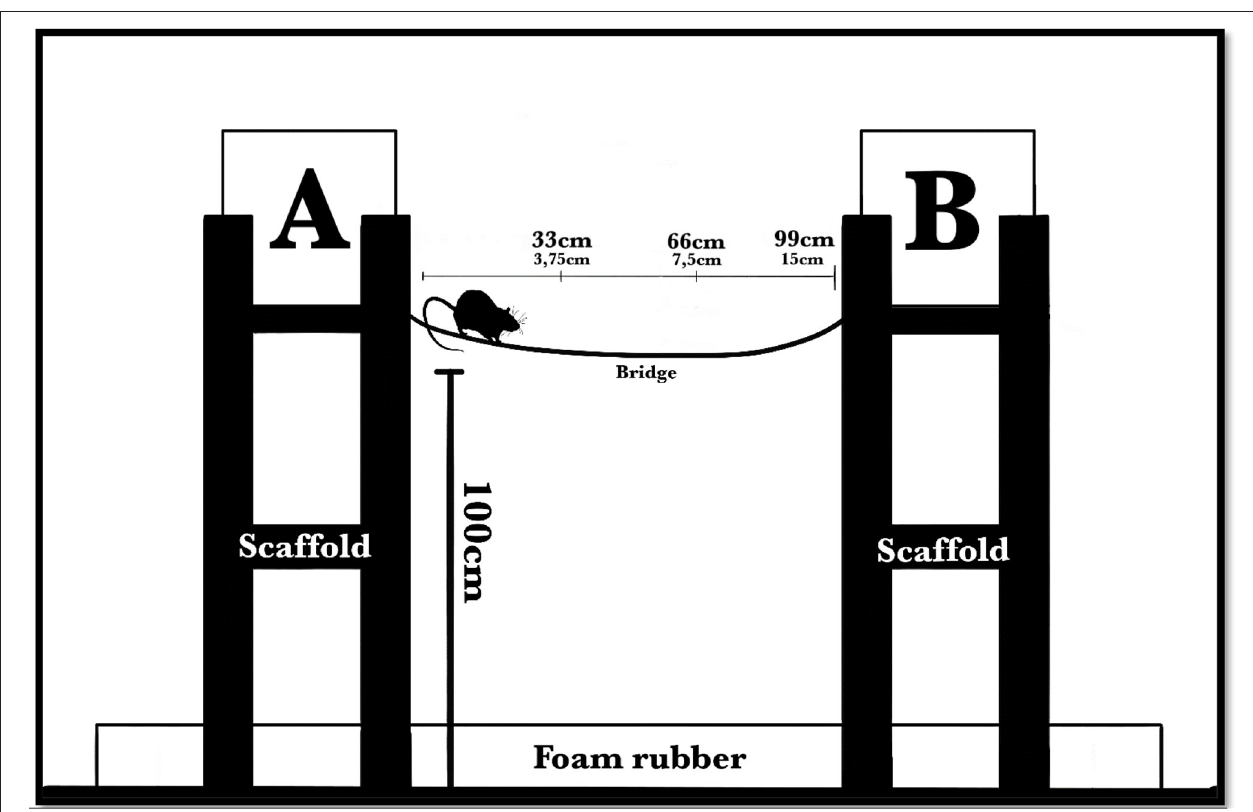
FIGURE 1 | The apparatus consisted of two plastic boxes (34 × 24 × 25cm each leaning on the long side), one of which was at the starting point (A) and the other at the end point ( B , containing pieces of food pellet), connected by a steel wire-mesh bridge that had a 5-cm width. Each box was placed on a wooden scaffold 1m above the ground, and the room floor was covered with foam rubber to avoid damage to subjects in the event of a fall. The distance between the boxes depended on the length of the bridge used in specific phases of the procedure: first, 33cm long, with a 3.75-cm difference in level (midway bending); second, 66cm long, with a 7.5-cm difference in level; third, 99cm long, with a 15-cm difference in level. Lastly, the 99-cm bridge was made unstable by means of short chains suspending it to the end scaffold; eventually, we added a “gap” between the bridge and the end scaffold, requiring a little jump as the last